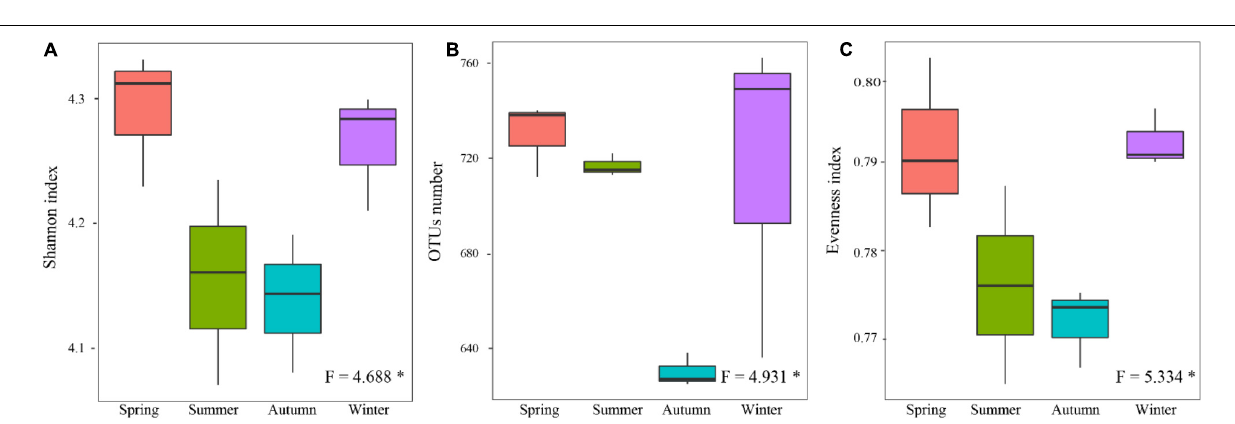
FIGURE 4 | Seasonal changes in alpha-diversity of the rhizospheric soil bacterial community in P . tabulaeformis forest located on Qinling Mountains. (A) Shannon; (B) OTU richness; and (C) Evenness. The horizontal bars within boxes represent the median. The tops and bottoms of boxes represent 75th and 25th quartiles, respectively. The upper and lower whiskers extend 1.5 × the interquartile range from the upper edge and lower edge of the box, respectively. ∗ P < 0.05, ∗∗ P < 0.01, and ∗∗∗ P <